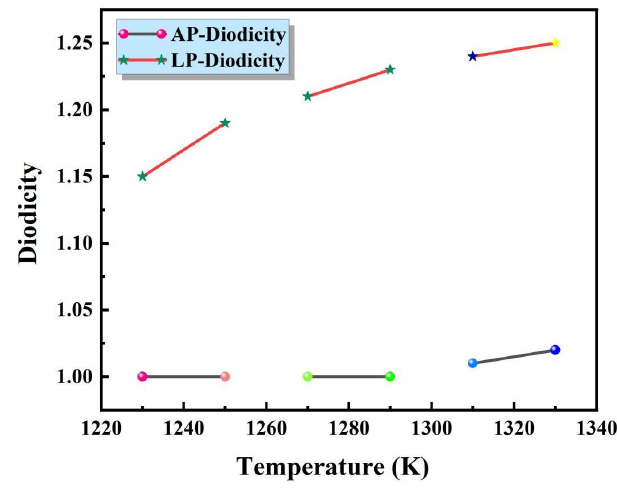
Figure 13. Change in diodicity with temperature.